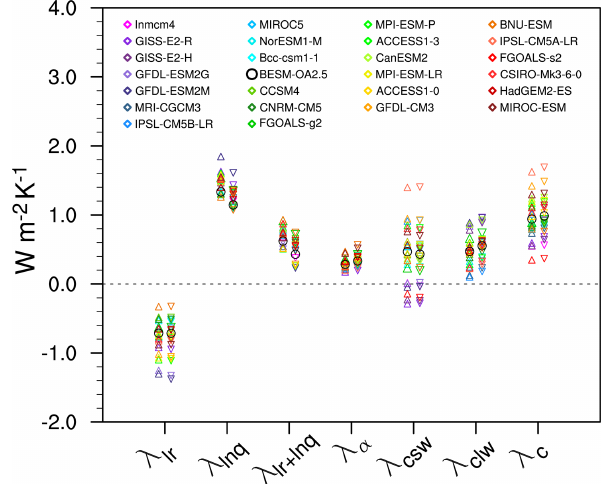
Figure 3. Global mean feedbacks for 25 CMIP5 models and BESM- OA2.5 (circle). Changes in abrupt4xCO2 relative to the piCon- trol were averaged over years 120–150. The triangles represent the mean estimated feedback values calculated using the NCAR radia- tive kernel, whereas the upside-down triangles represent the esti- mated feedback values calculated using the GFDL radiative